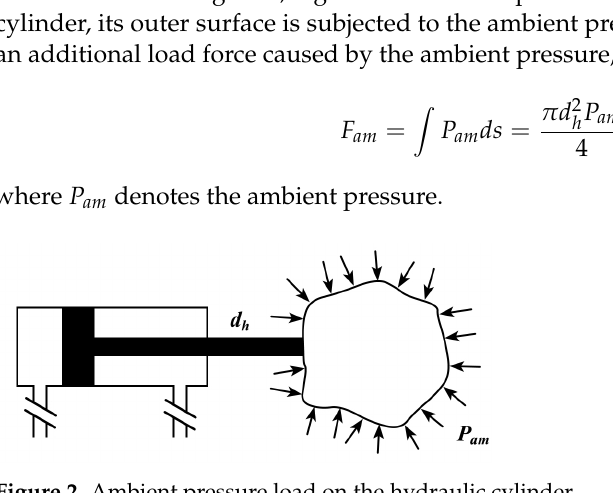
Figure 2. Ambient pressure load on the hydraulic